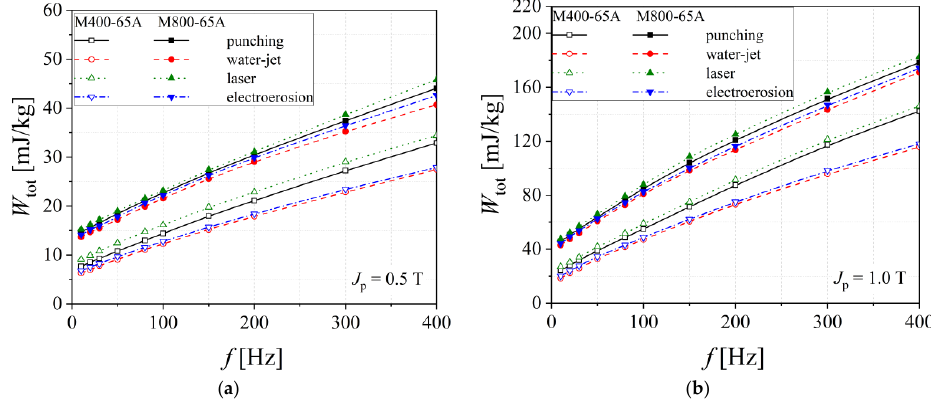
Figure 5. Total energy loss versus frequency measured at J p = 0.5 T ( a ) and J p = 1.0 T ( b ), in the case of M800-65A and M400-65A electrical steels. M800-65A and M400-65A electrical